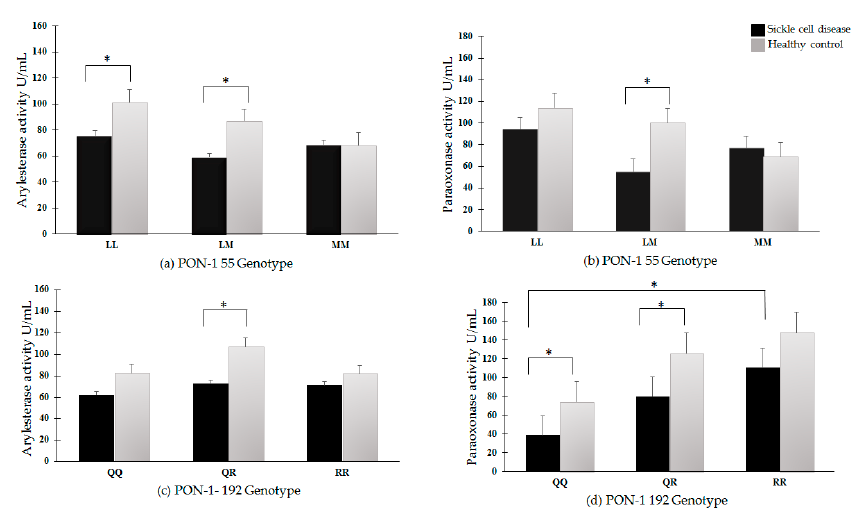
Figure 1. Serum PON-1 arylesterase and paraoxonase activities in subjects with PON-1 L55M and Q192R polymorphisms. ( a ) Arylesterase activity and PON-1 L55M polymorphisms; ( b ) Paraoxonase activity and PON-1 L55M polymorphisms; ( c ) Arylesterase activity and PON-1 Q192R polymorphisms; ( d ) Paraoxonase activity and PON-1 Q192R polymorphisms. * P < 0.05 .